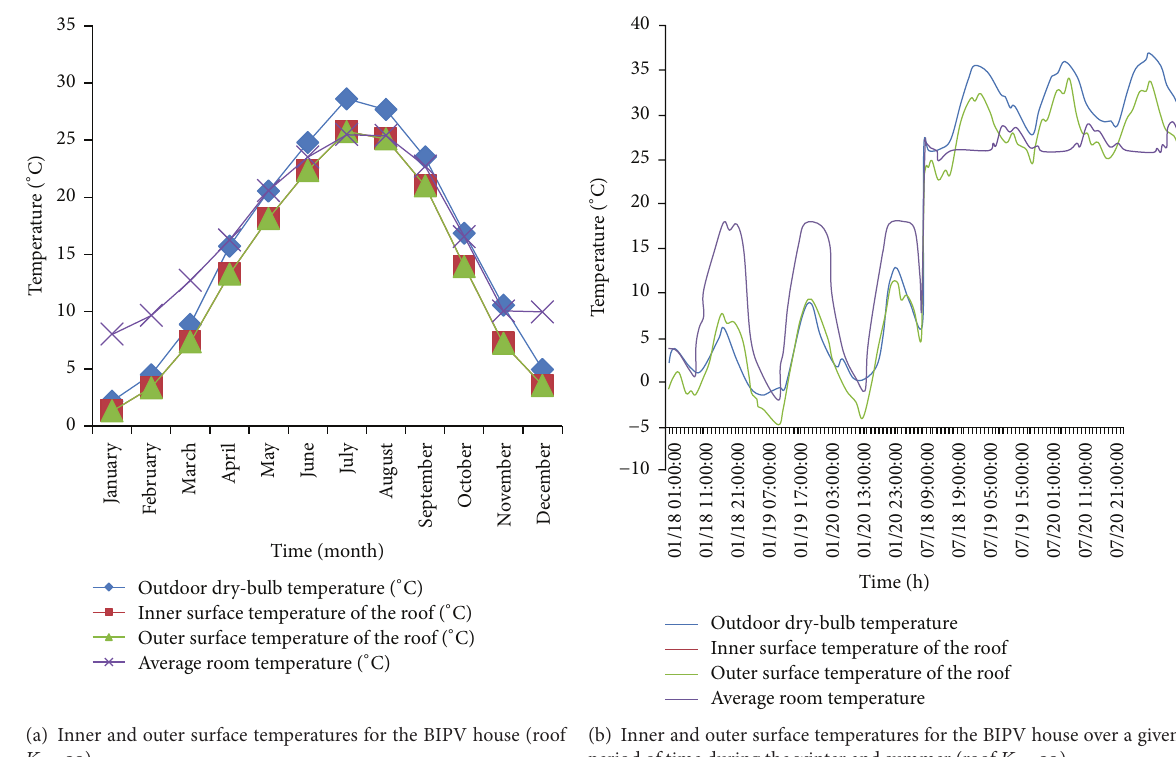
Figure 10: Simulated inner and outer surface temperatures for the BIPV house (roof 𝐾 = ∞ ).